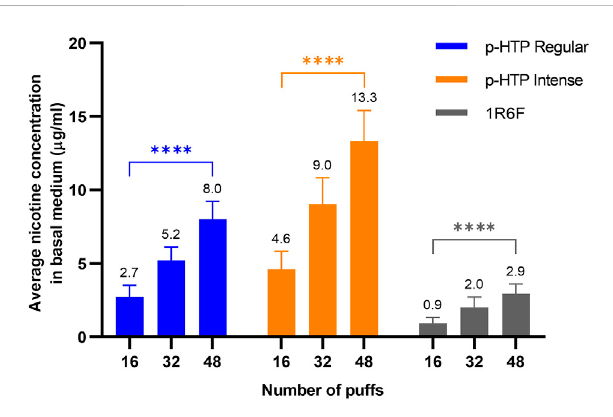
FIGURE 2 Average (values detailed above each bar) nicotine concentration in basal cell culture medium samples collected directly following exposure ofthe3Dtissuesto16,32or48puffsofp-HTPaerosols(diluted1in2)or 1R6F reference cigarette smoke (diluted 1 in 14). Data is an average of measurements in samples taken at the timepoints detailed inFigure 1. Error bars represent standard deviation; n = 3 per day x 12 days. Differencesbetweenthepufflevelsofeachproductwereanalysedusing atwo-way ANOVA; **** p < 0.0001 (two-wayANOVA with Tukey ’ spost- hoc